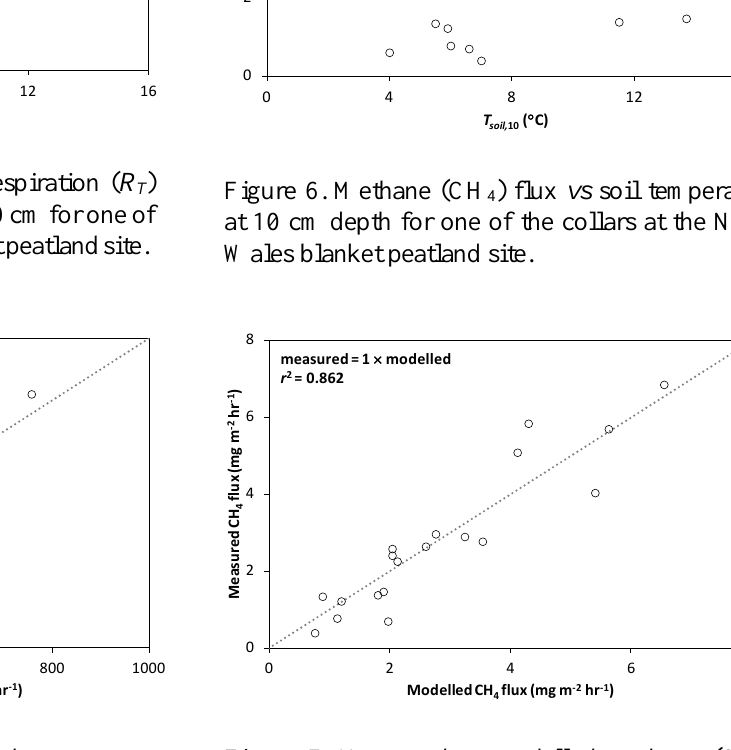
Figure 7. Measured vs modelled methane (CH flux for one of the collars at the North Wales blanket peatland site. The dotted line is the 1:1